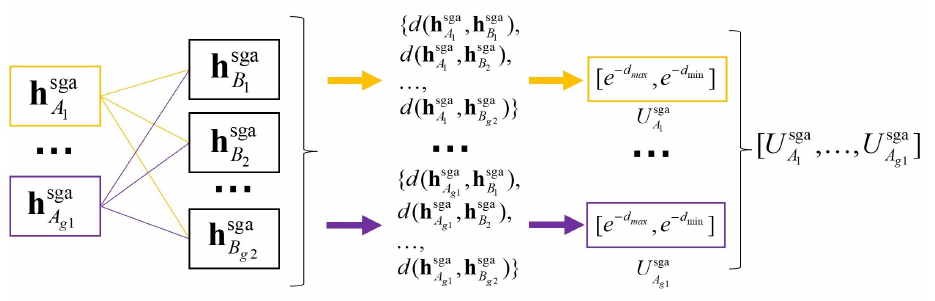
Figure 6. Schematic diagram of Formula